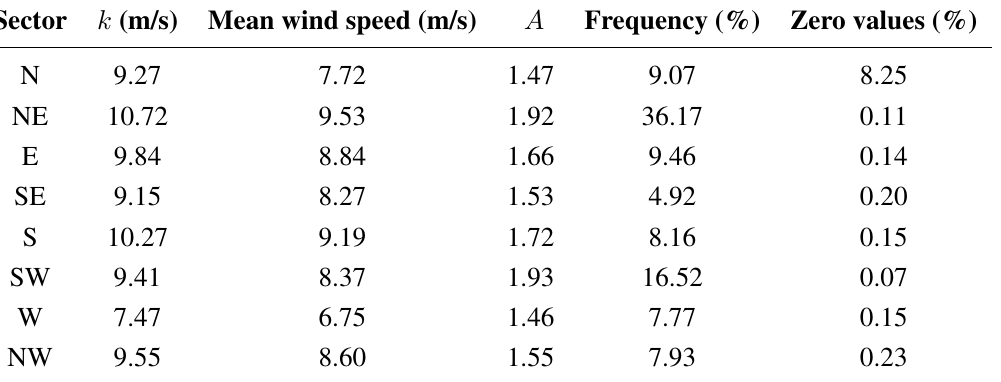
Table 5. Stats table of the modified Weibull fit for wind speed at Búrfell at a 55-m height.